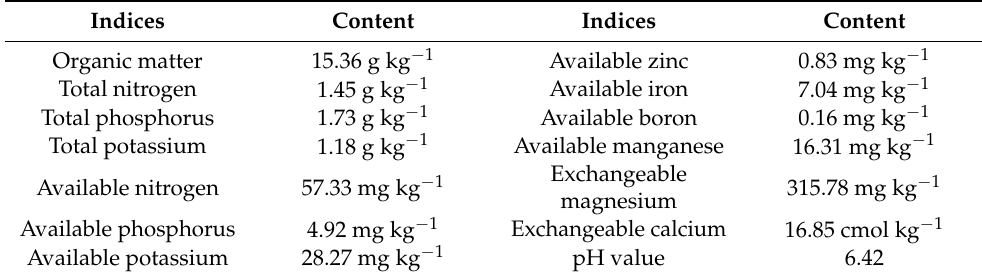
Table 1. The fertility information of the potted